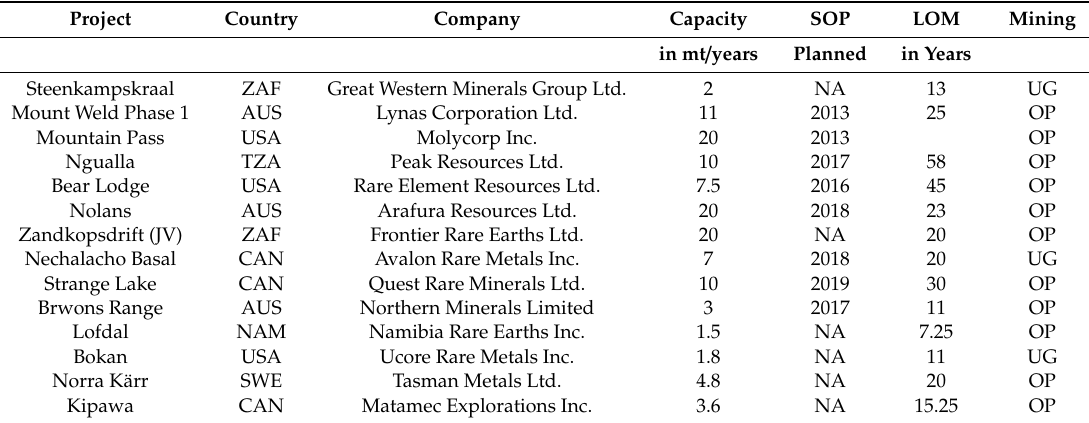
Table 1. Overview of the 14 focus projects outside of China [10–33,40].